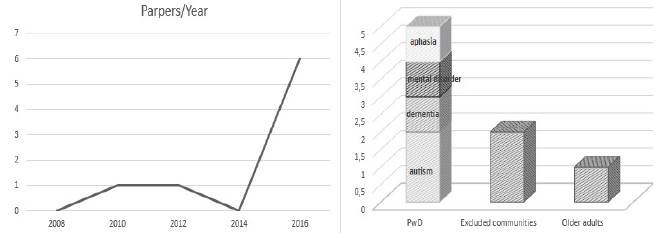
Fig. 1. PDC papers per year and issues